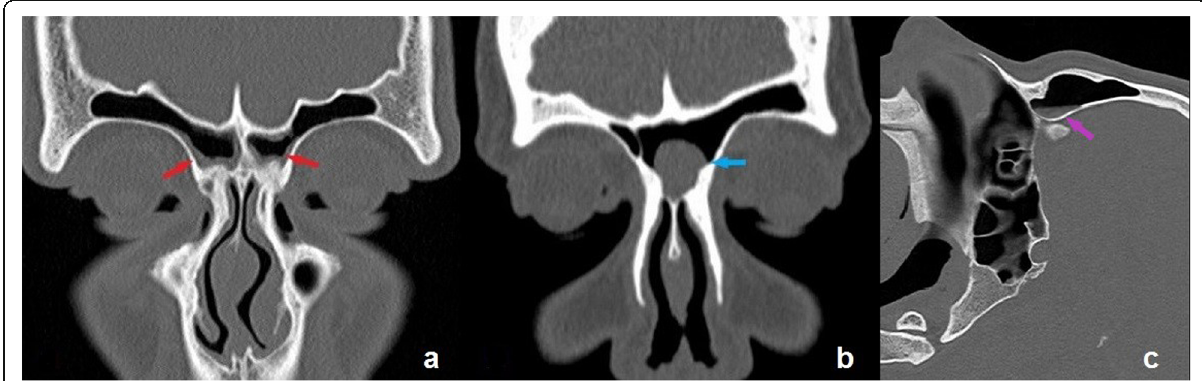
Fig. 3 Coronal ( a , b ) and sagittal ( c ) computed tomography sections demonstrating mucosal thickening (red arrows), retention cyst/ polyp (blue arrow), and fluid collection (purple arrow) which are taken as the criteria of the presence of frontal